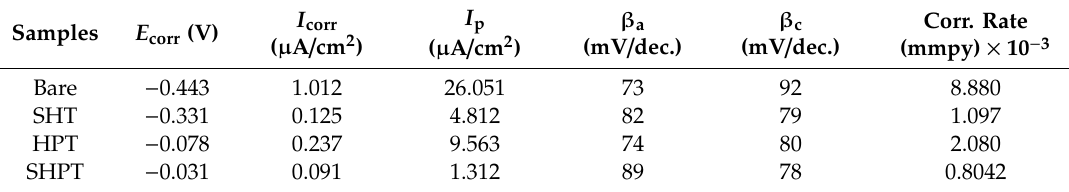
Figure 5. PDP curves of treated specimens in SBF medium. Table 1. Tafel parameters of bare and treated TNZ specimens.